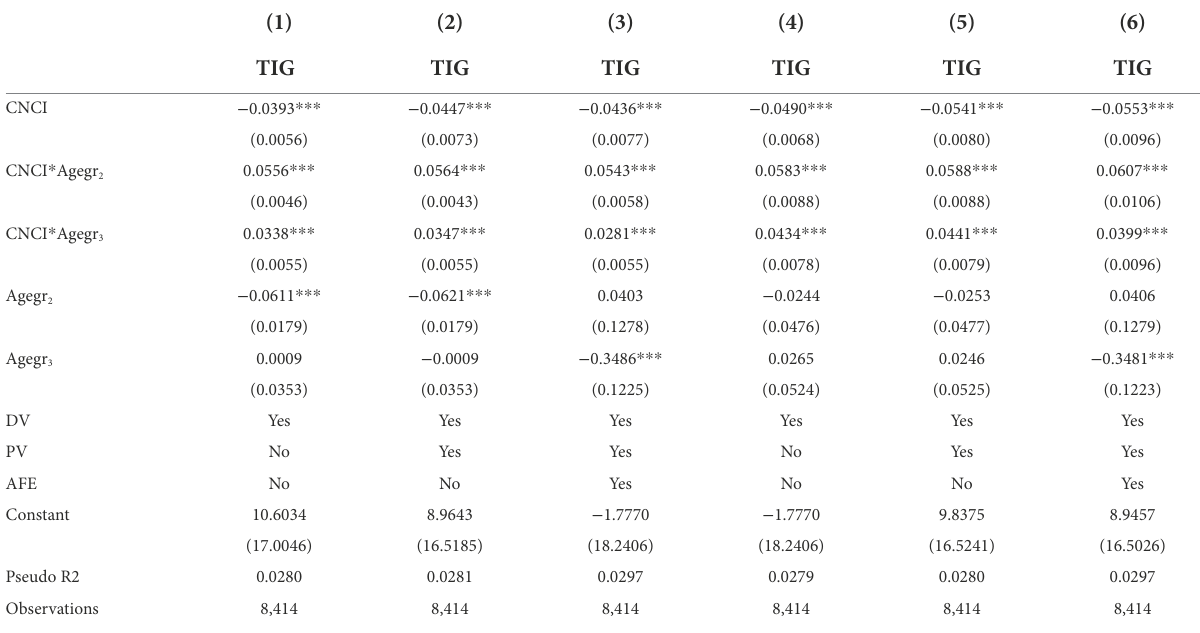
TABLE 11 Robustness test: Changing the age